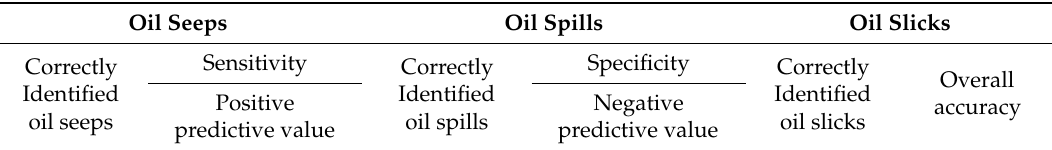
Table 3. Condensed confusion matrix form (i.e., Table 1) showing the statistical metrics (i.e., Table 2) explored herein to evaluate our linear discriminant analysis (LDA) algorithms. Oil Seeps Oil Spills Oil